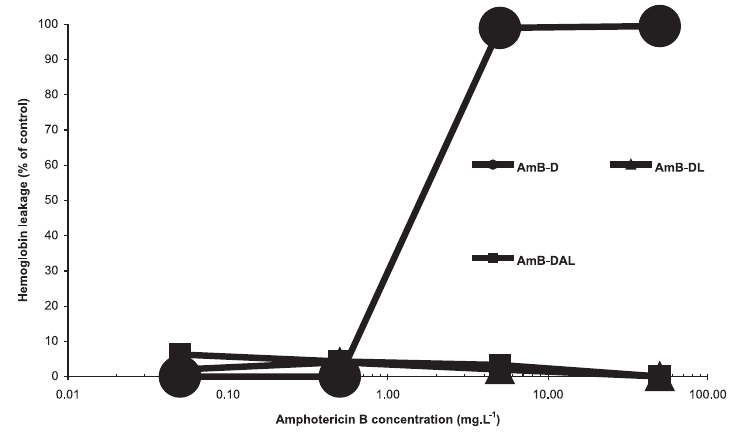
FIGURE 1 – Average of percentage and standard desviation of hemoglobin leakage from RCB under action of AmB-D , AmB-DL or AmB-DAL, respectively